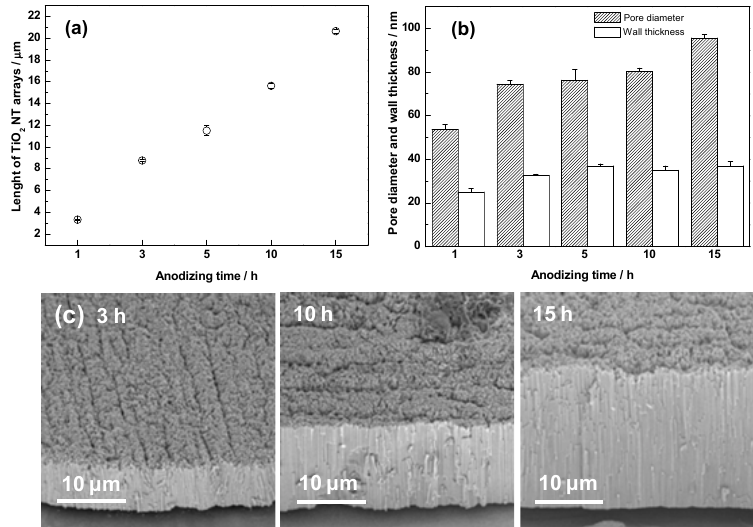
Figure 10. Geometry of TiO 2 NT arrays: ( a ) length; and ( b ) pore diameter and wall thickness as a function of anodising time; ( c ) cross-sectional SEM images of TiO 2 NT arrays for 3 h, 10 h, and 15 h under 60 V applied potential in the electrolyte containing 0.5 wt% NaF and 5 wt% water. Reprinted with permission from [14]. Copyright 2011 American Chemical Society.